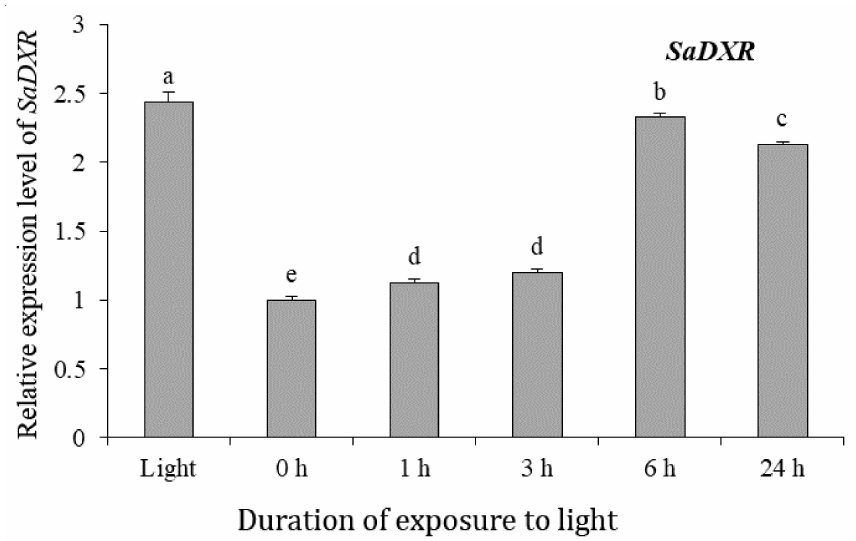
Figure 7. Expression profile of SaDXR in 40-day-old S. album etiolated seedlings that were exposed to light. S. album seeds were germinated in the dark for 20 days then grown into 10 cm-etiolated seedlings for other 20 days. Subsequently, etiolated seedlings were exposed to light for 0, 1, 3, 6, 24 h or grown in a 16-h photoperiod. Each value represents the means of three independent biological replicates ± SD. Different letters above bars indicate significant differences (DMRT, p <